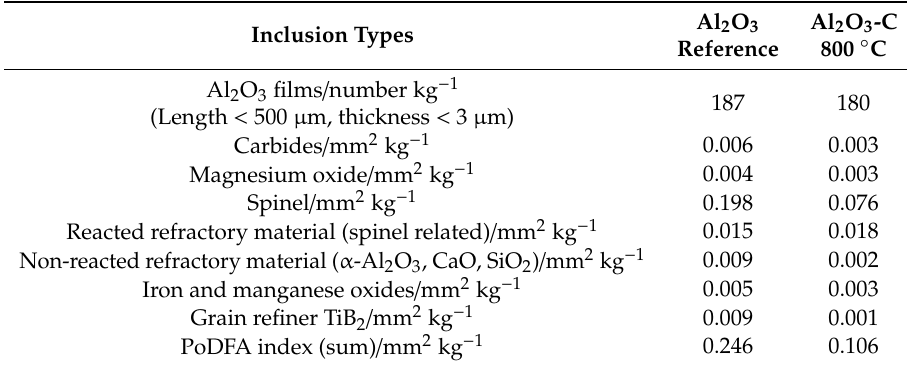
Table 3. Results of the PoDFA analysis of the filtration trial 1, regarding the filtered melt. Inclusion